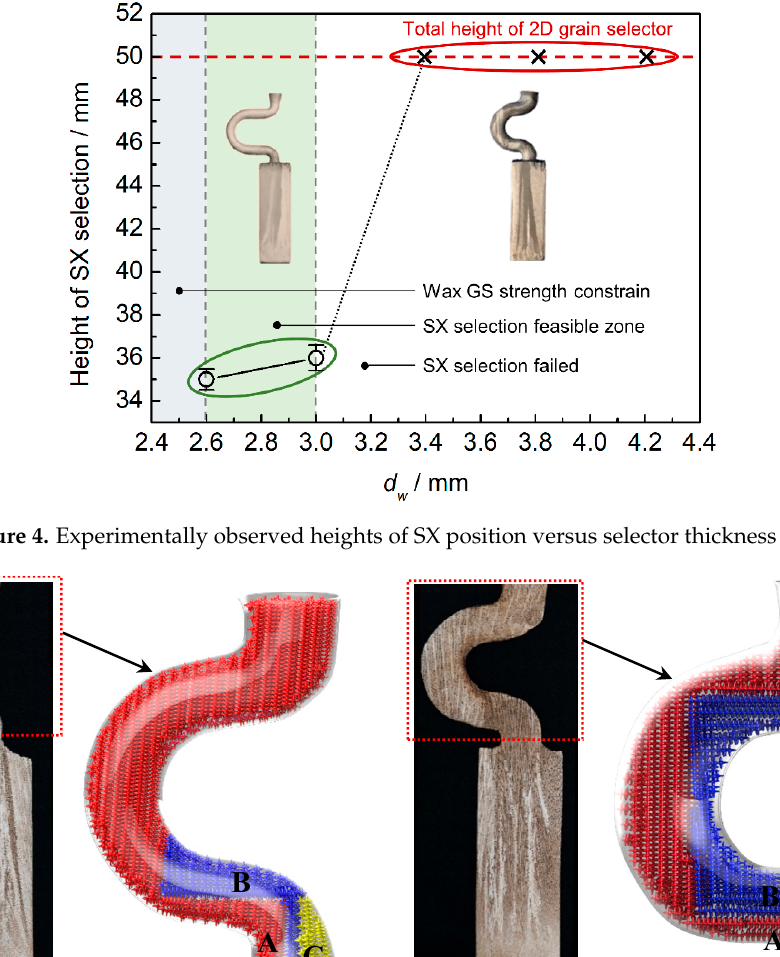
Figure 4. Experimentally observed heights of SX position versus selector thickness ( d w ).